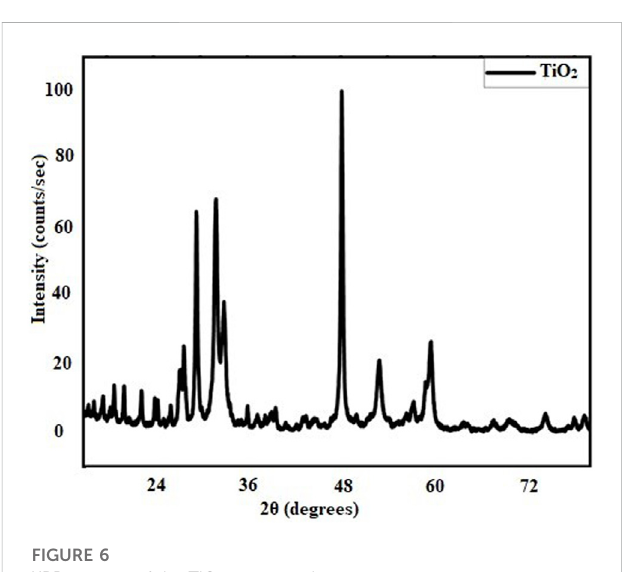
XRD spectra of the TiO 2